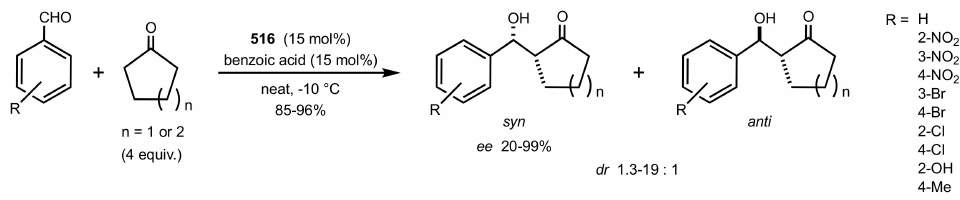
Scheme 135. Aldol reaction catalysed by the organocatalyst 516 .